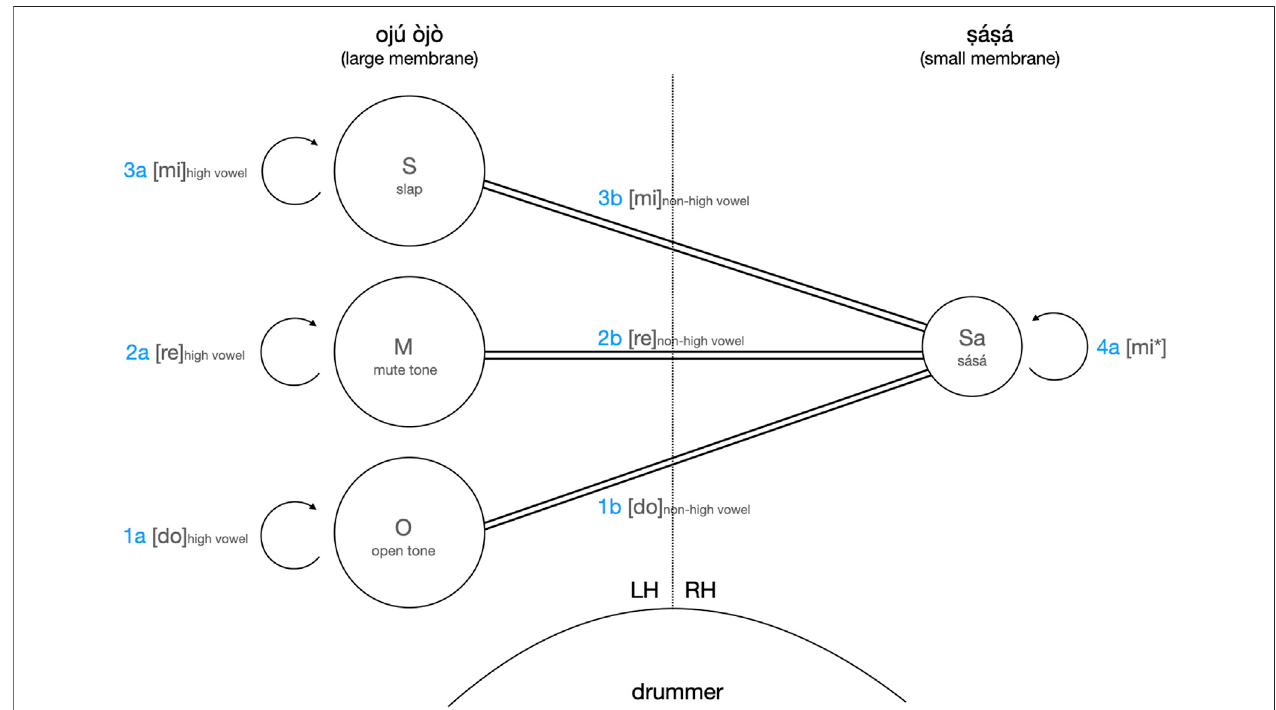
FIGURE 5 | Graphic representation of the ìyáàlù bàtá speech surrogacy